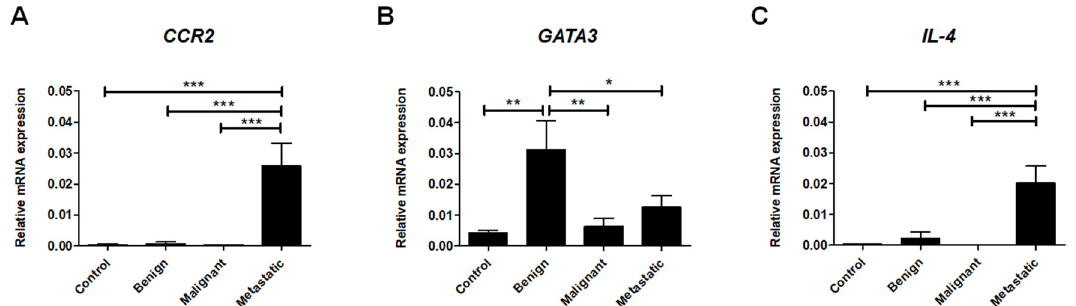
Figure 4. Th2 cell-associated gene expression levels in canine mammary tumors. The relative gene expression of CCR2 ( A ), GATA3 ( B ), and IL-4 ( C ) in healthy mammary gland tissue (Control) and in benign, malignant, and metastatic canine mammary tumors. The results are presented as the mean ± SEM. A one-way ANOVA and Tukey HSD post hoc test were applied. Significance levels are indicated as follows: * p < 0.05; ** p < 0.01; *** p < 0.001.